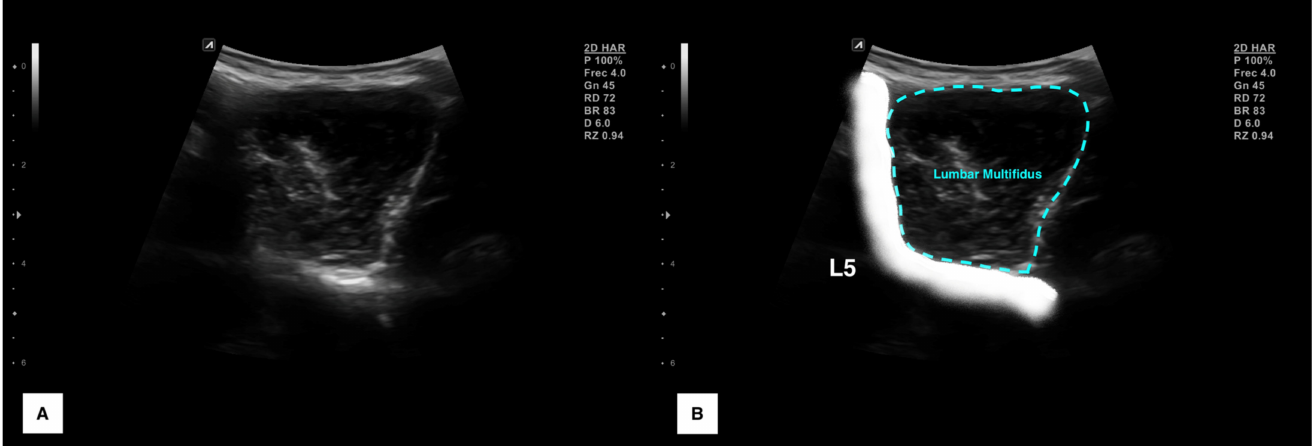
Figure 2. Ultrasound imaging acquisition and measurement: Raw image of the lumbar multifidus muscle acquisition at L5 ( A ) and structures identification with muscle contouring ( B